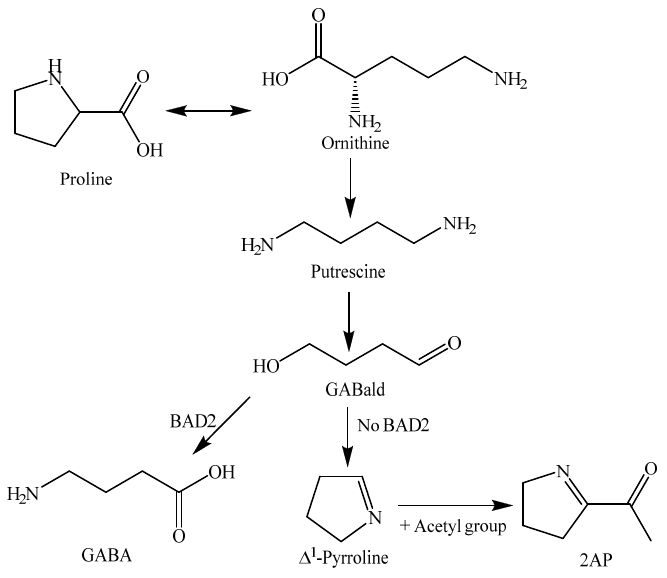
Figure 15. 2-Acetyl-1-pyrroline (2AP) biosynthesis pathways in rice [149]. Abbreviations: GABald, γ- aminobutyraldehyde; BAD2, betaine aldehyde dehydrogenase; GABA, γ-aminobutyric acid.